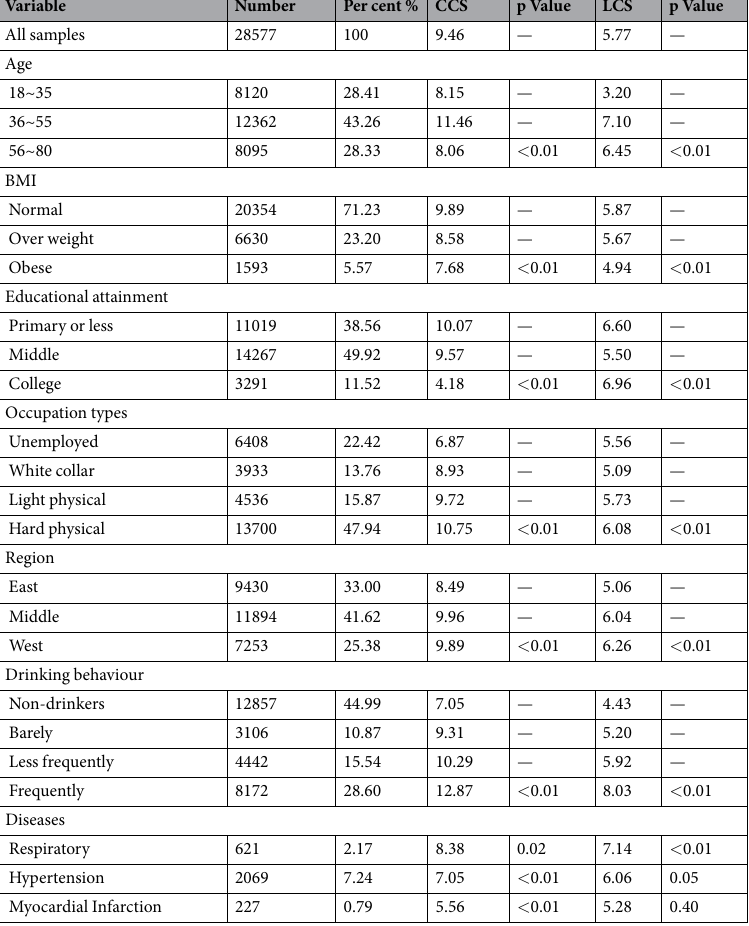
Table 1. Descriptive Statistics of Sample. The p Values came from F tests between